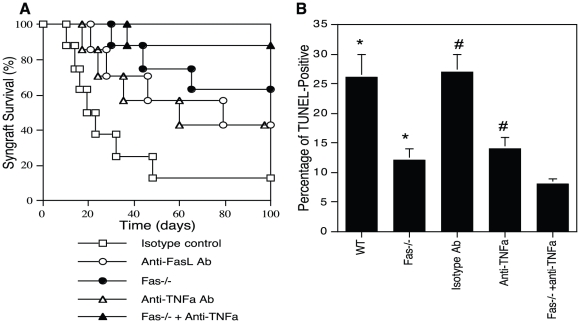
Blocking Fas and TNF receptor death pathways induces long-term IPCC graft survival in syngeneic WT mice.WT.B6-derived IPCCs were transplanted to WT B6 recipients that were treated with isotype Ab (Open square, n = 8), anti-FasL (Open circle, n = 7), or anti-TNFα Ab (Open triangle, n = 7). IPCCs derived from B6.Fas-/- ASCs also were transplanted to WT B6 recipients that were either untreated (Filled circle, n = 8) or treated with anti-TNFα Ab (Filled triangle, n = 8). IPCC syngraft rejection was then observed (A). IPCC graft cell apoptosis was determined by PDX-1 staining and a TUNEL method (B), as described in Figure 3. One representative of three separate experiments is shown.